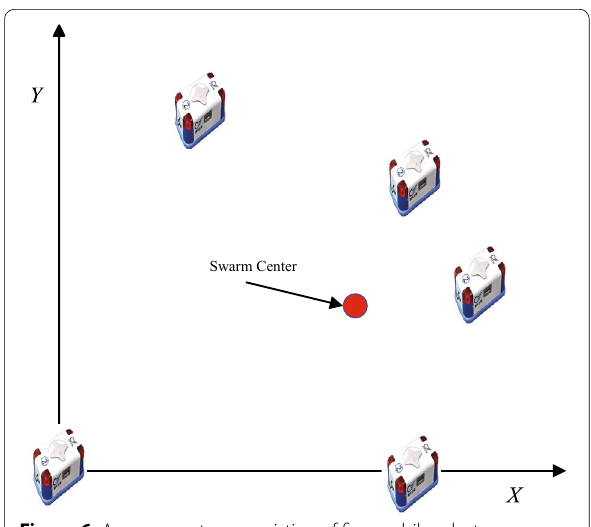
Figure 6 A swarm system consisting of five mobile robots